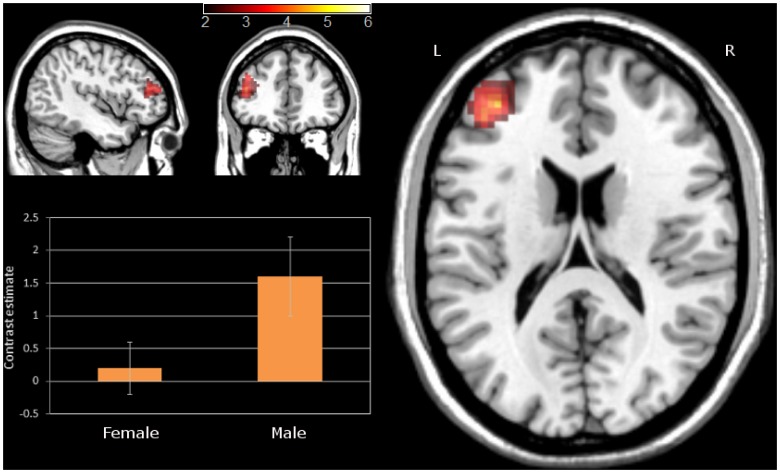
Differences between lying and truth-telling in men and women in the left middle frontal gyrus area.The bar chart represents the mean contrast value of the cluster. The activation is superimposed on a Colin27 template image in the MNI space. The colored bar represents t-values; L – left side; R- right side.